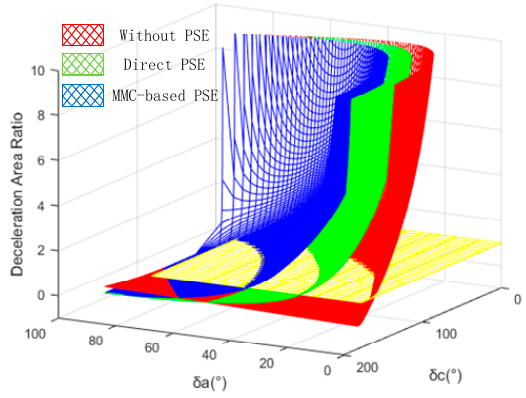
Figure 6. Effective boundary 3D map of three technologies.